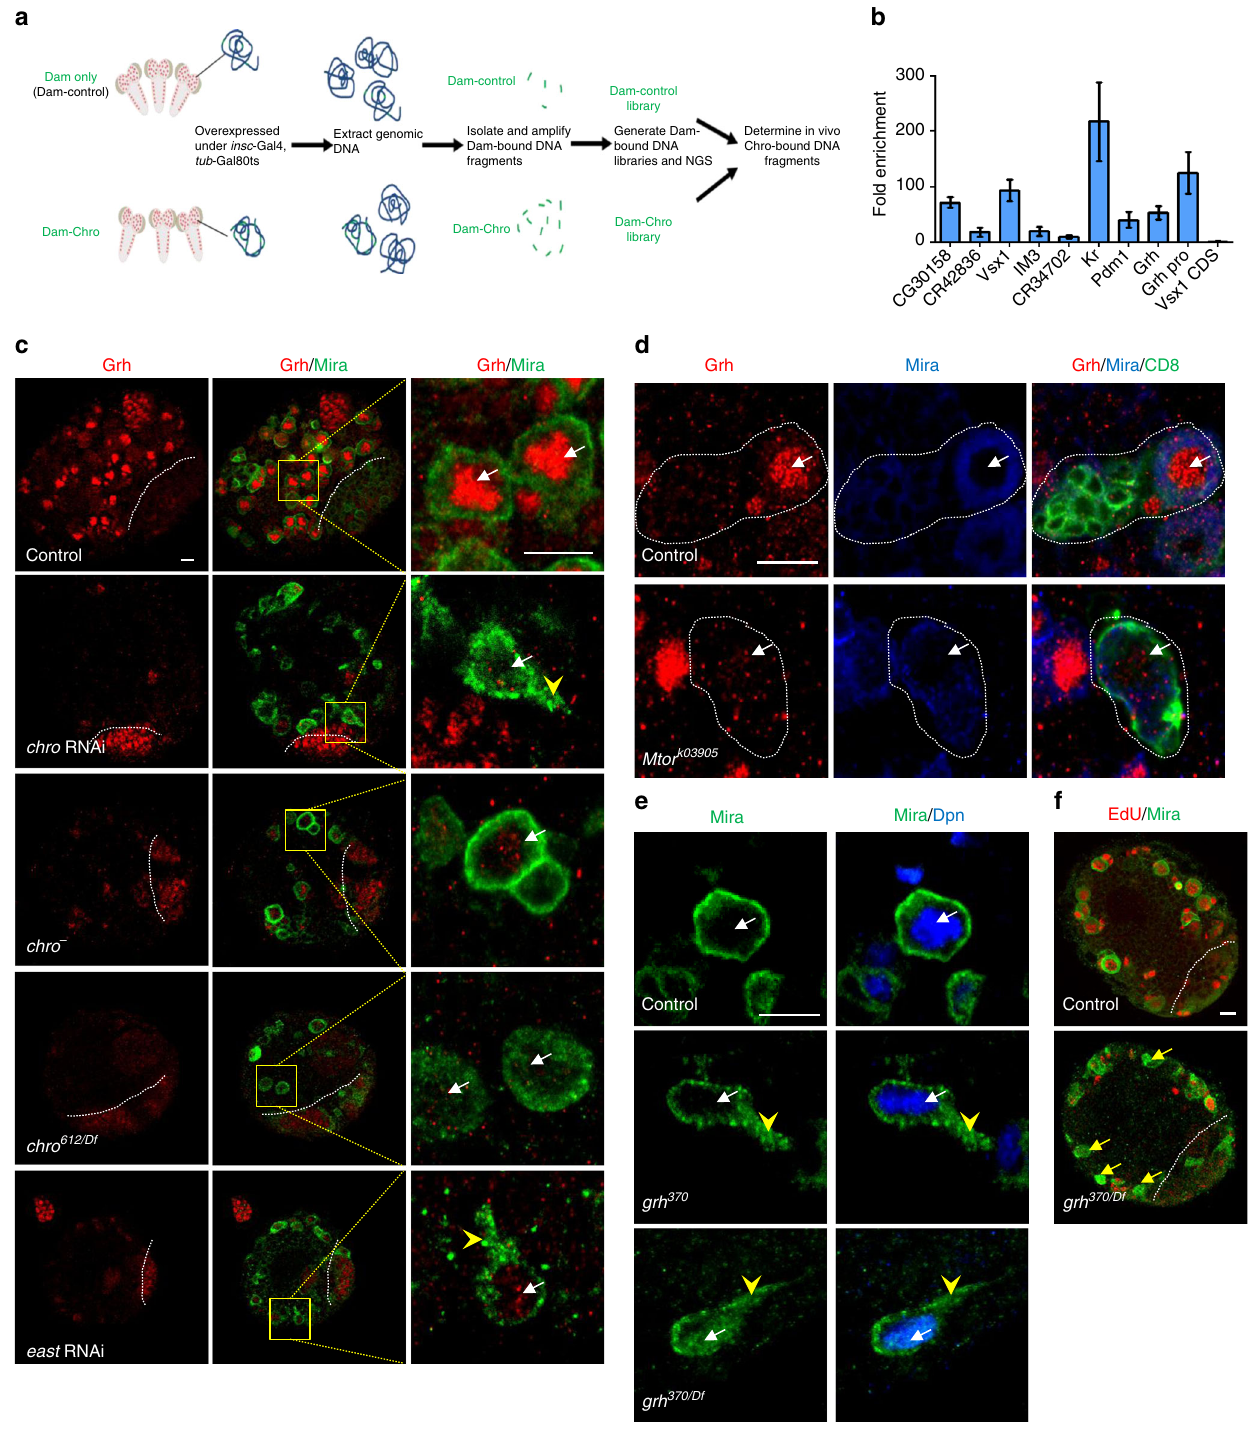
Fig. 3 Chro promotes Grh expression during NSC reactivation. a A diagram of in vivo pro fi ling of Dam-control and Dam-Chro in NSCs. b Quanti fi cation of fold enrichment in ChIP-qPCR assay using anti-Chro and control (anti-IgG) based on various predicted Chro-binding sites. The CDS region of Vsx1 is used as control. Error bars indicate ± SD. c Control, chro RNAi, chro − , chro 612/Df and east RNAi third-instar larval brains were labelled with Grh and Mira. The right panels are enlarged views of regions in the yellow boxes . d NSC clones from control and Mtor k03905 were labelled with Grh, Mira and CD8. NSC clones were outlined by white dotted lines . e Mira and Dpn were labelled in control, grh 370 and grh 370 /Df(2R)PcLB ( grh 370/Df ) NSCs. NSCs with cellular extensions, control, 0%, n = 616; grh 370 , 5%, n = 426; grh 370/Df , 11%, n = 672. f Larval brains from control and grh 370/Df were labelled with EdU and Mira. Yellow arrows indicated Mira + EdU − NSCs in grh 370/Df . The central brain is to the left of the white dotted line in c and f . White arrows indicated NSCs in c , d and e , and arrowheads indicated the cellular extension of NSCs in c and e . Scale bars, 10 µ